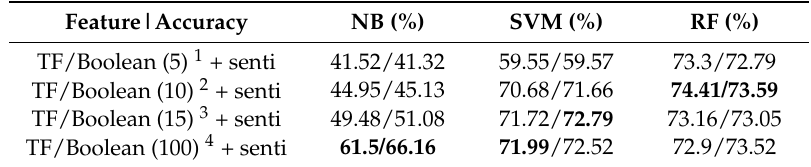
Table 7. The accuracy of gender detection using different feature set.